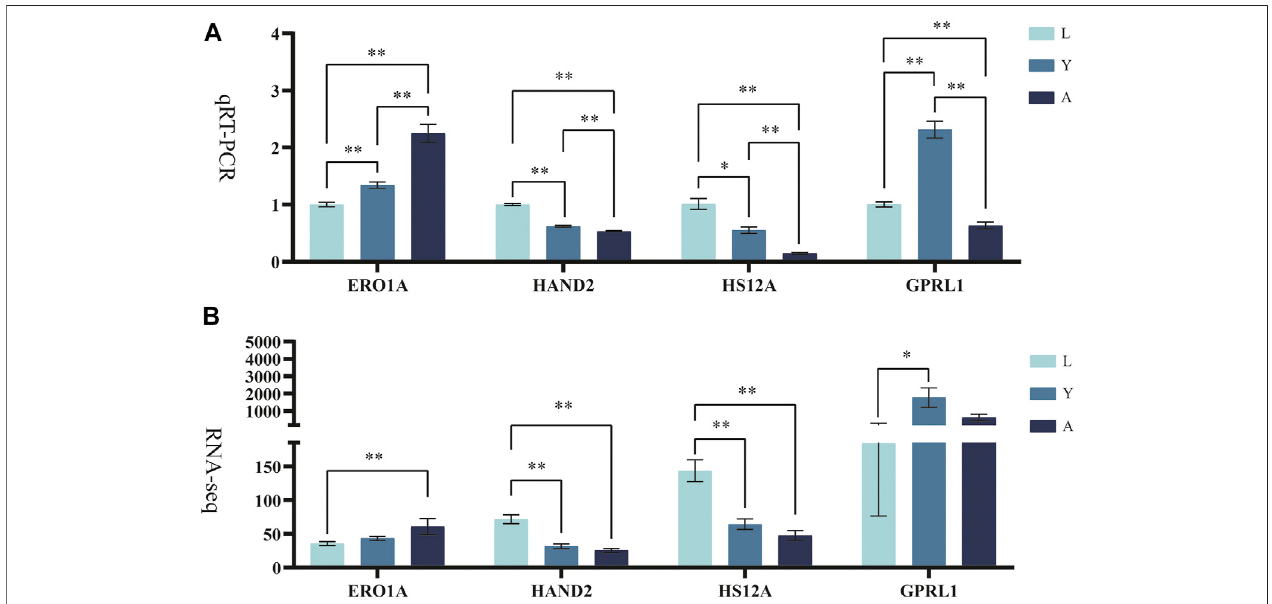
FIGURE 8 | Validation of candidate genes. (A) qRT-PCR, RO21 was used as the reference gene. (B) FPKM represents RNA-seq relative expression.* means p < 0.05, ** means p < 0.01.